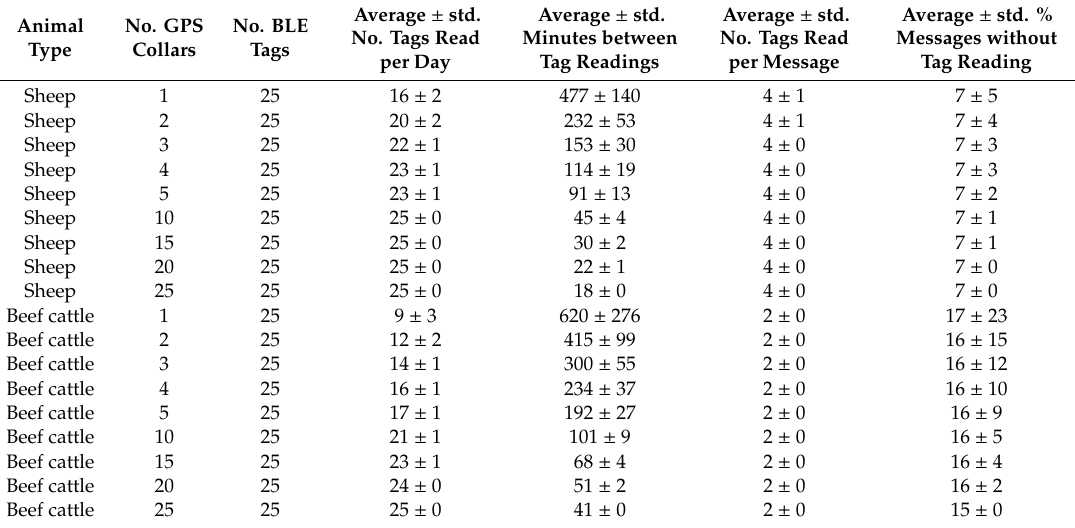
Table 1. Performance of BLE tag messages reception depending on the number of GPS